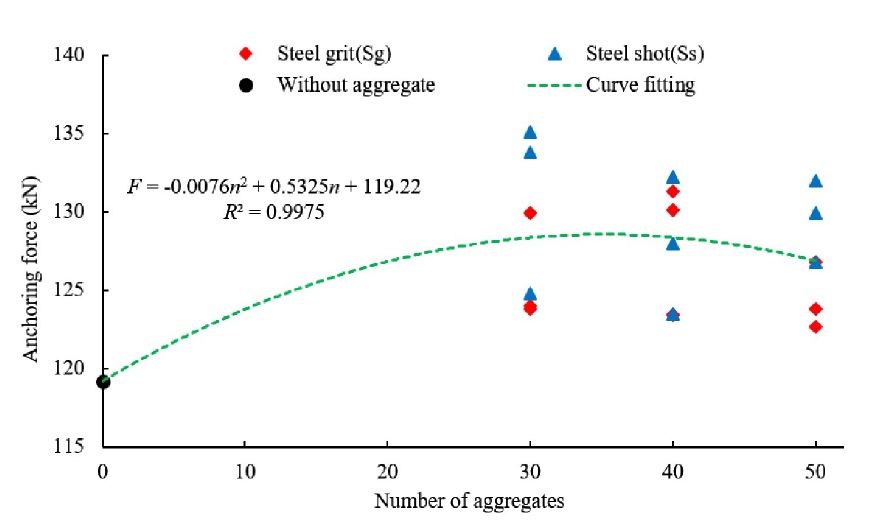
Fig 15. Scatter plot of average anchoring force and fitting curve of different numbers of aggregates.